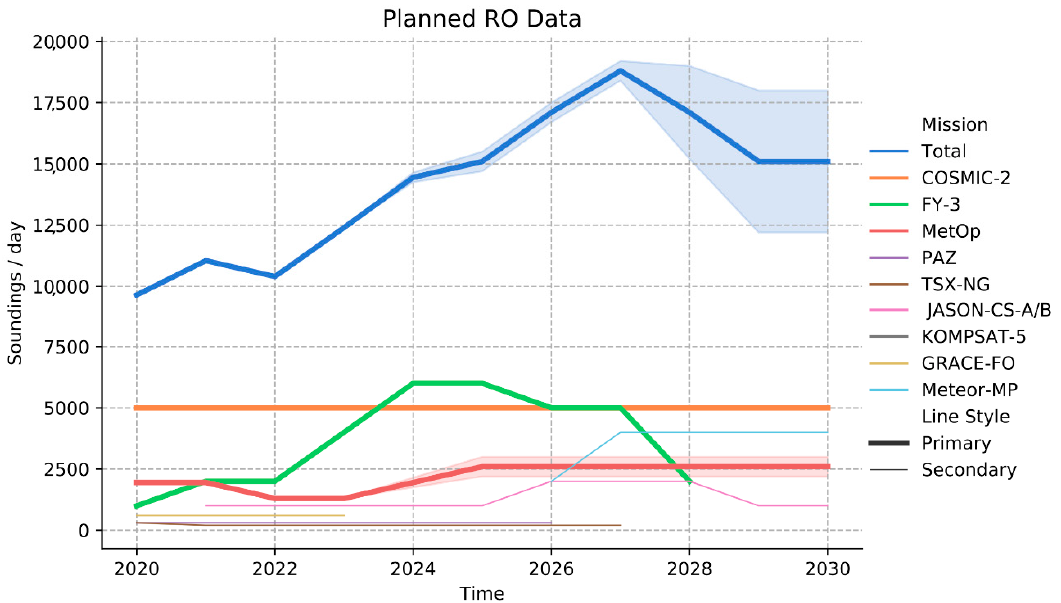
Figure 9. Planned RO data amount from 2020 to 2030 from all missions. The shadow area represents the estimates of possible RO data; the bold lines indicate three primary missions, namely, COSMIC, FY-3, and MetOp [12].